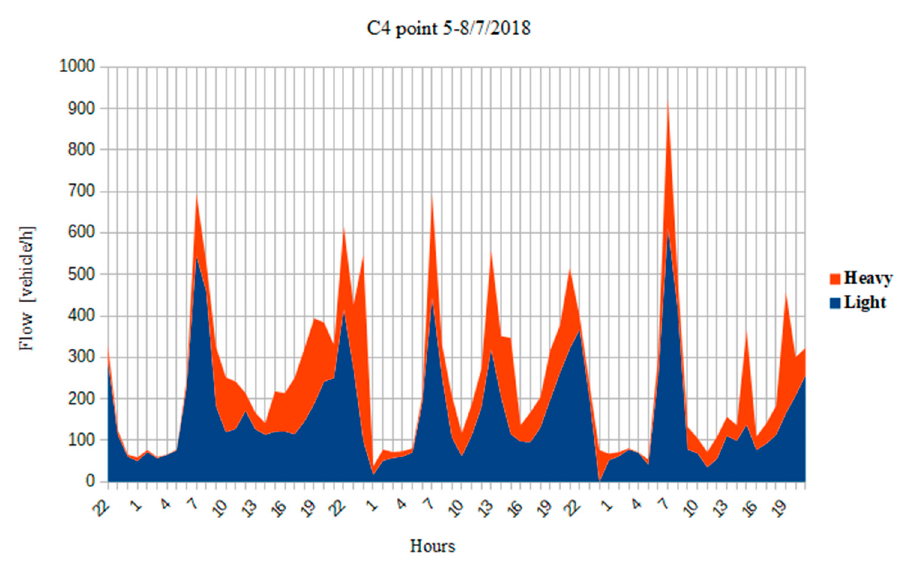
Figure 7. Vehicle flux measured in the proximity of Point C1 in July. In orange is the heavy vehicle flux, in blue is the light vehicle flux.